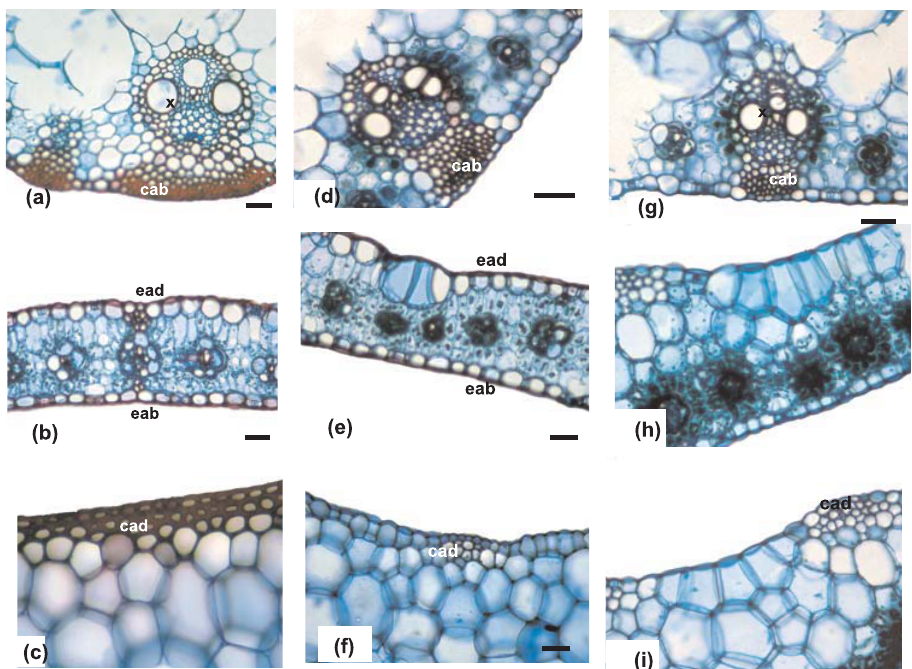
Figura 4. Alterações estruturais no tecido vascular, células epidérmicas e colenquimáticas de folhas de milho cultivadas em solo com doses crescentes de Cd. Folhas expostas a 20 mg kg -1 de Cd, (a-c) tratamento com calagem e (g-i) tratamento sem calagem; (d-f) tratamento-controle. x: xilema; cab: colênquima abaxial; cad: colênquima adaxial; eab: epiderme abaxial; ead: epiderme adaxial. Barras: 50 (cid:122) m.